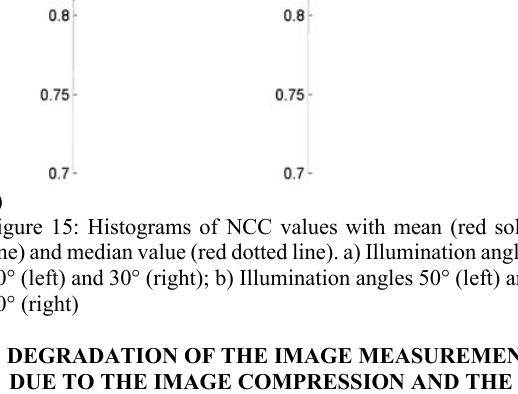
Figure 13: From top left to bottom right: crop of the image obtained at 70° of incidence angle, laser disparity map, uncompressed images disparity map, disparity map at ibr 63, 32, and16 ibr respectively.